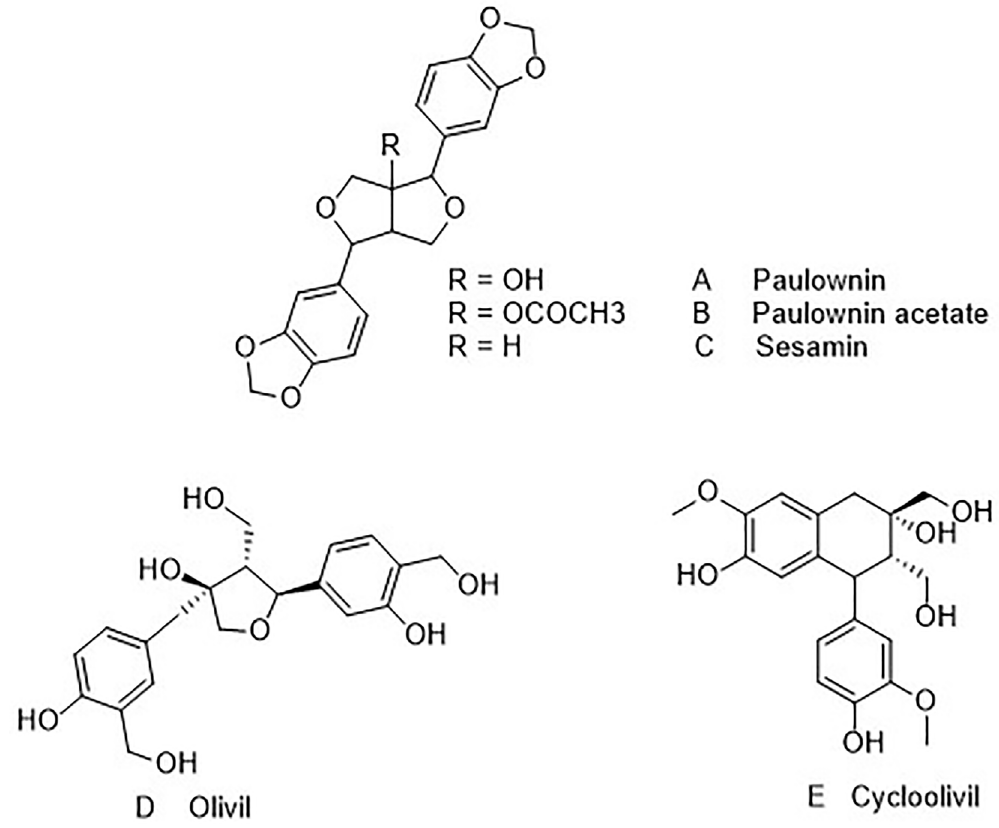
FIGURE 1 - Chemical structures of paulownin (A), paulownin acetate (B), sesamin (C), olivil (D) and cycloolivil